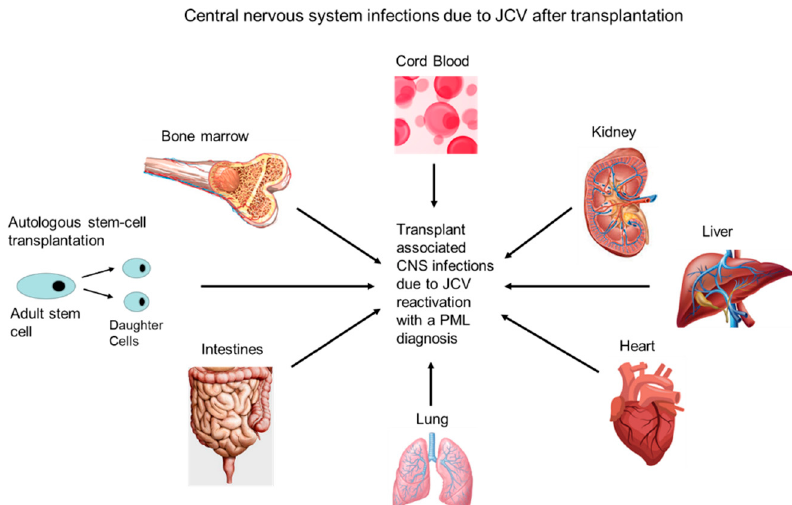
Figure 2. Transplantation and PML. Reported types of human transplantation (cord blood, kidney, liver, heart, lungs, intestines, autologous stem cells, and bone marrow) associated with a PML clinical diagnosis following iatrogenic immunosuppression. The image of the cord blood was obtained and modified from BioCord: “Researchers find new breakthrough in search for cure for blood cancers”; images of the kidney, liver, heart, and lungs were obtained and modified from Pearson Education 2012 for the image of alveolar organization that was modified (unpublished data); and images of the intestines and bone marrow were obtained and modified from National Geographic Kids: “Human Digestive System and from Health Visions, bloodless bone marrow transplants Narayana Health City respectively”.